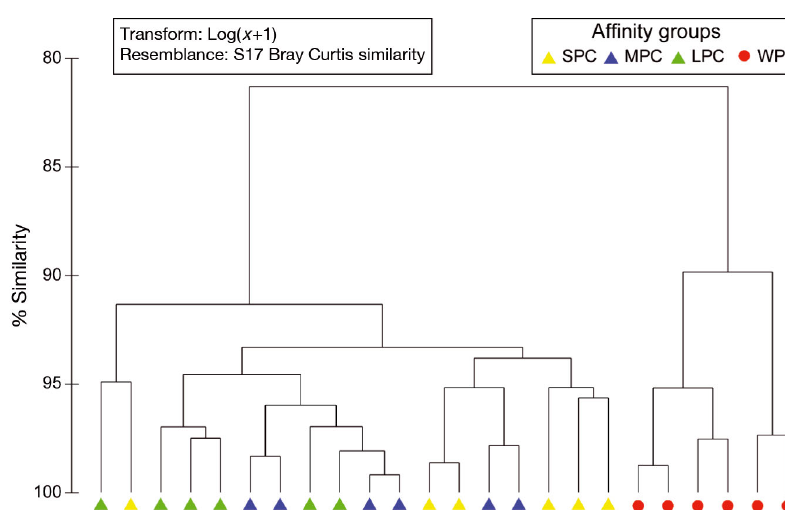
Fig. 1. Hierarchical cluster analysis groups of the fatty acid profiles of wild (WP), and small, medium and large cultured Hediste diversicolor (SPC, MPC and LPC,